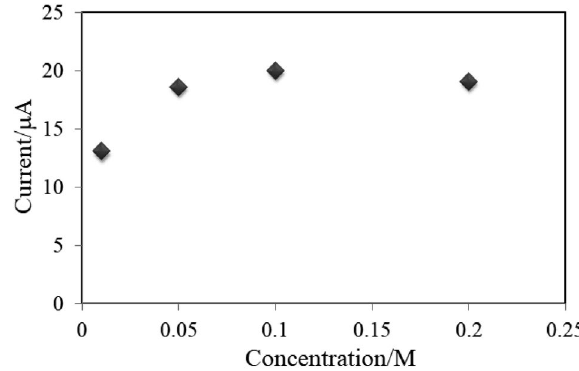
Figure 5. Variation of anodic peak current with 10 mM glucose in different concentrations of